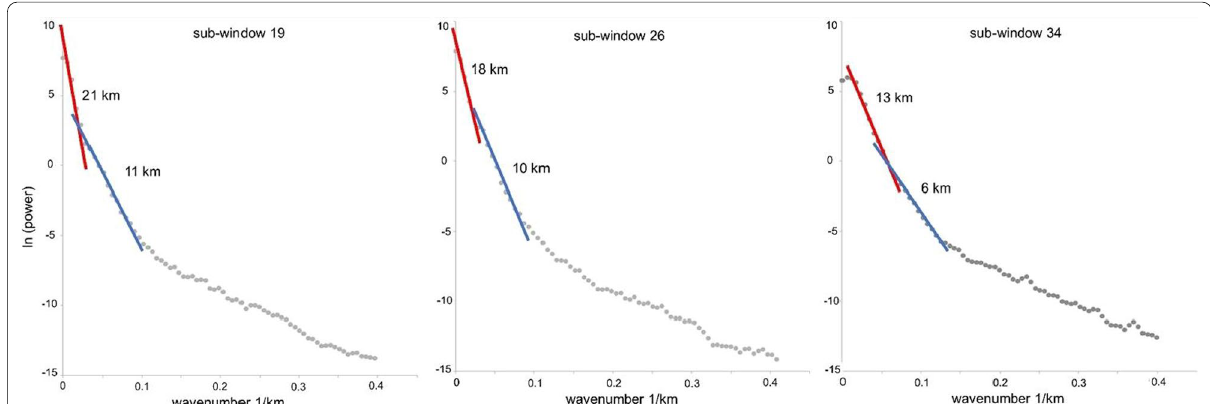
Fig. 8 Two-dimensional (2-D) radially averaged power spectral curves of some representative blocks extracted from 1-degree by 1-degree sub-windows of the FAA anomaly map in the Sulu Sea. See Fig. 7 for the sub-window location